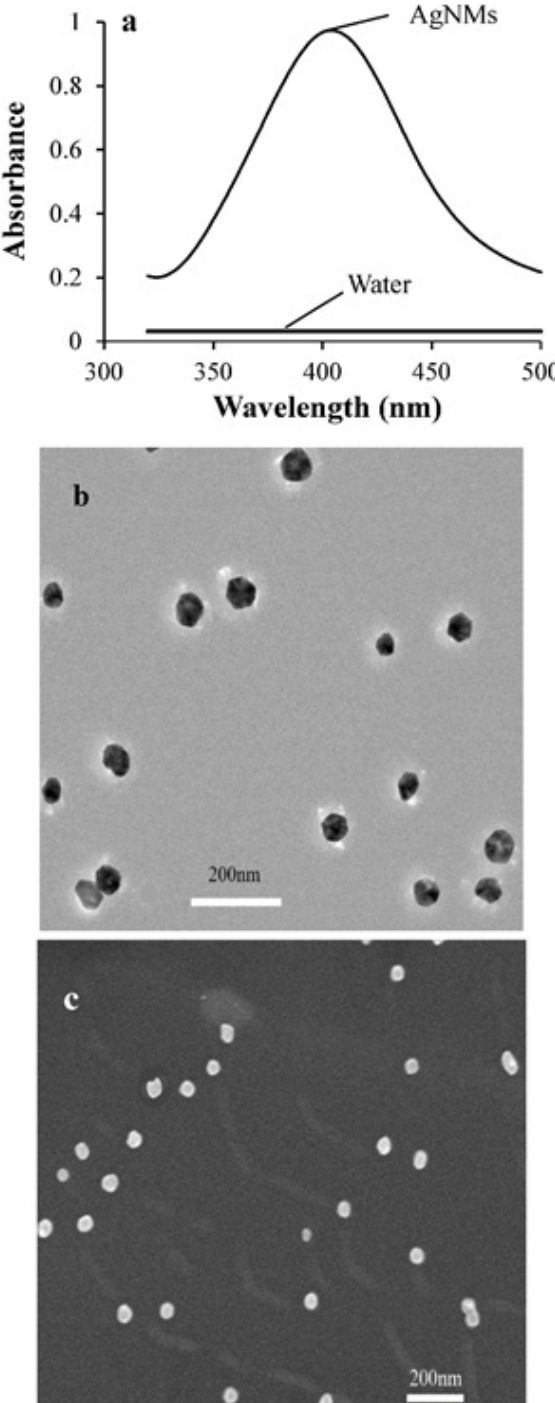
Figure 4: Characteristics of AgNPs in water solutions a: UV-vis absorption spectrum of the AgNPs b: TEM image of the AgNPs c: SEM image of the